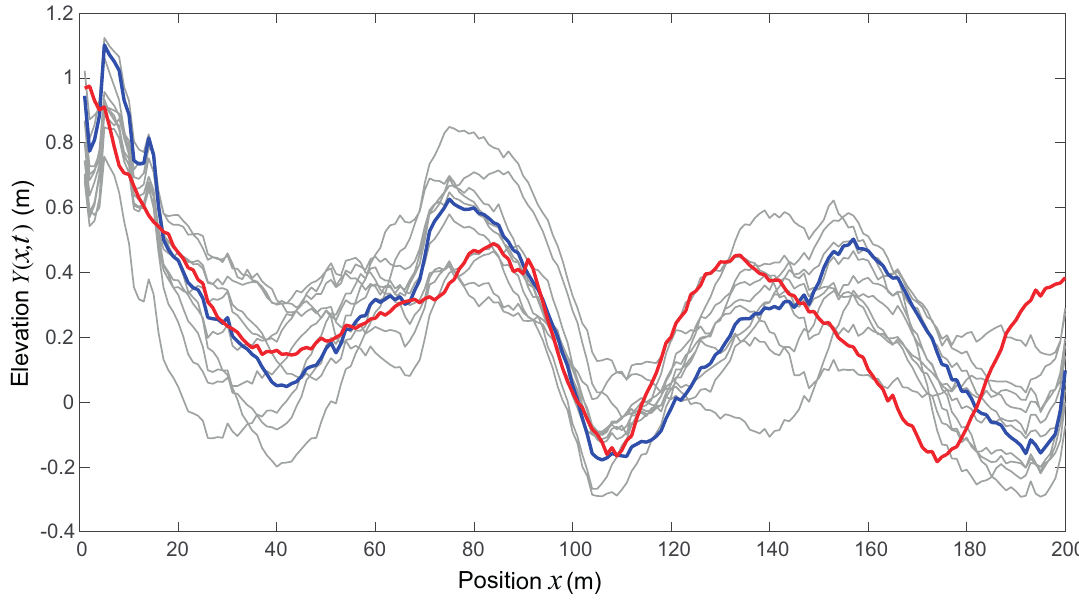
Figure 10. Illustration of the simulation procedure for profile P48 and a time lag τ = 34 days, where the 10 (out of 10,000) simulated profiles at time instant t + τ (gray lines) are all conditioned on the same initial observed values at time instant t (blue line) and where simulated profiles need to be compared to observed values at time t + τ (red line). For the sake of readability, only the centered values Y ( x , t ) = Z ( x , t ) − (cid:98) µ ( x ) around the average profile (cid:98) µ ( x ) are represented